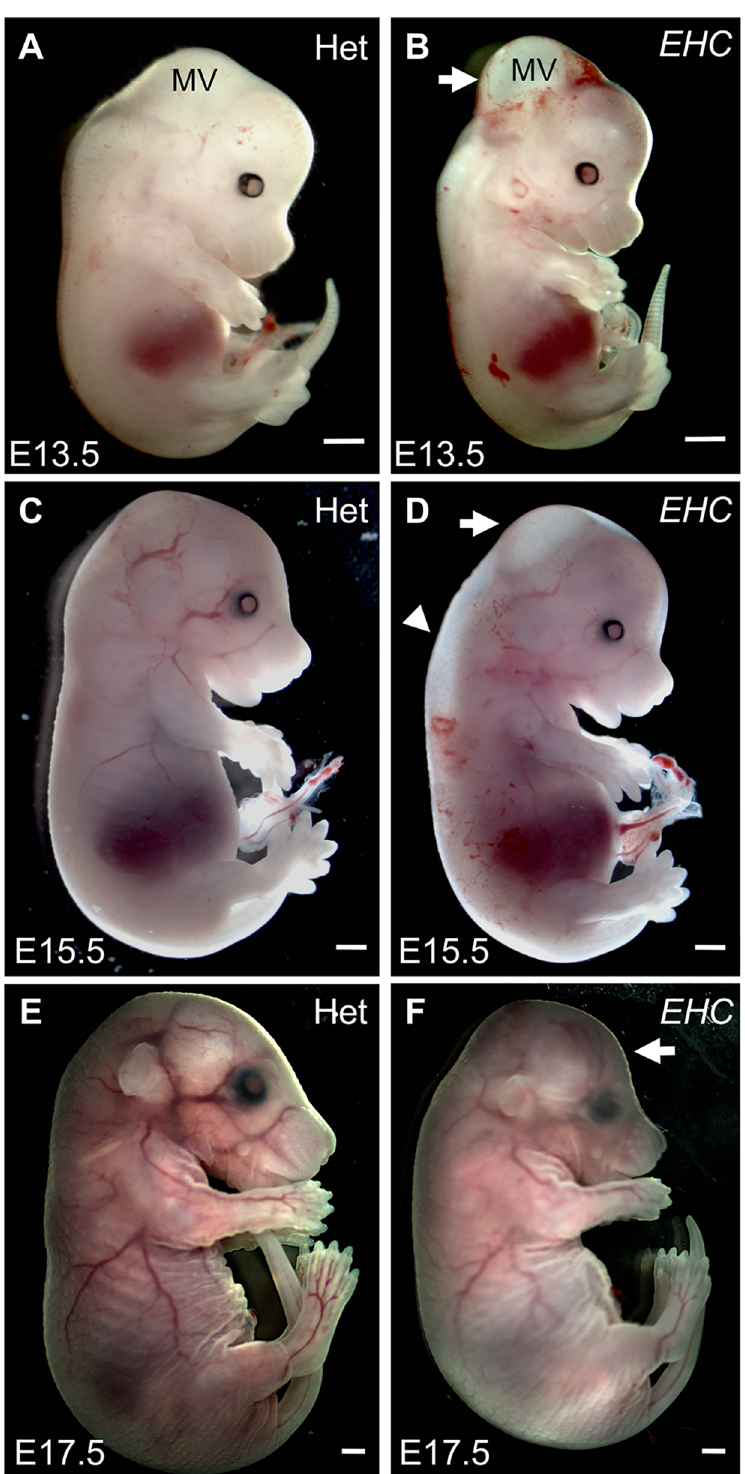
Fig 3. EHC mutant embryo morphology. A: Heterozygous littermate at E13.5. B: EHC mutant displays hydrocephalus in the mesencephalic vesicle (white arrow). C: Heterozygouslittermate at E15.5. D: EHC mutant at E15.5 displaysreducedhydrocephalus (arrow), althoughoedemain the spinalcord regionis apparent(arrowhead). E: Heterozygouslittermate at E17.5. F: EHC mutant has dome-shaped